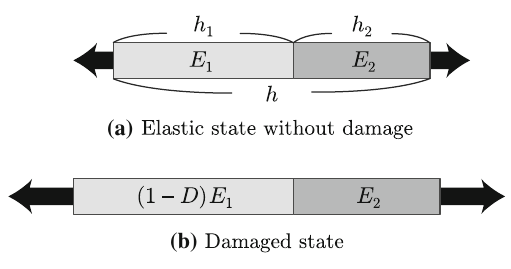
Fig. 1 Tensile problem of an elastic bar comprising two materials: a elastic state without damage; b damaged